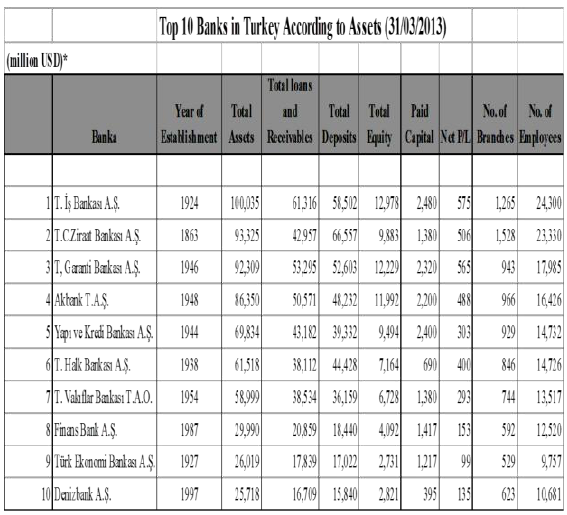
Table 3: Ranking of Turkish banks